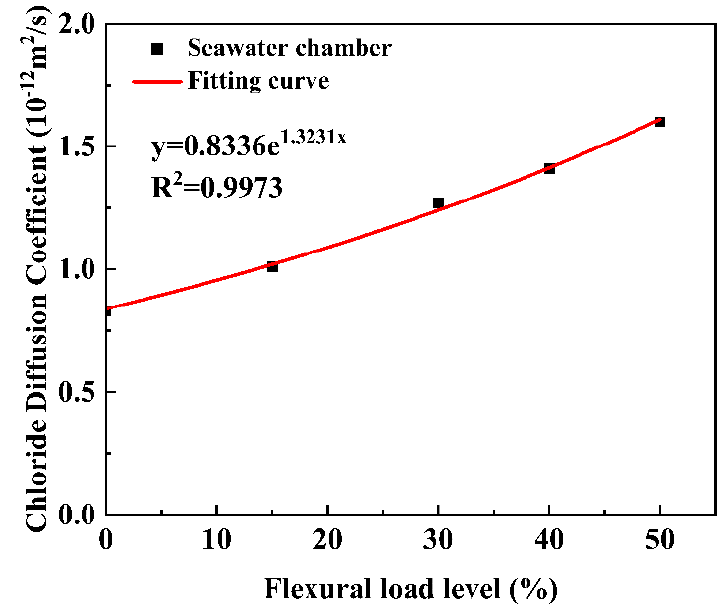
Figure 2. Influence of flexural stress on the chloride diffusion coefficient of concrete.